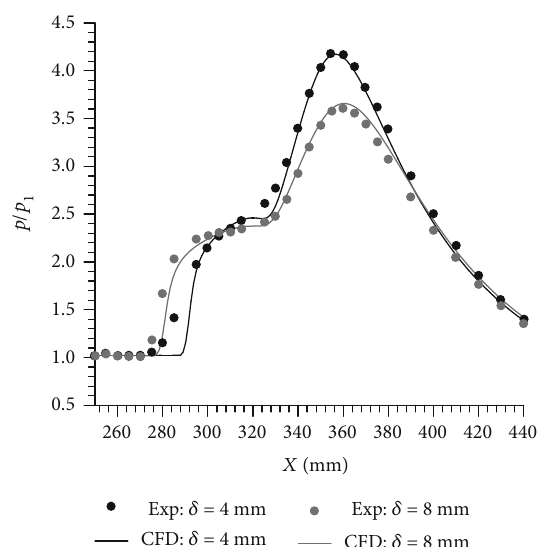
Figure 5: Comparison of static wall pressure of CFD and